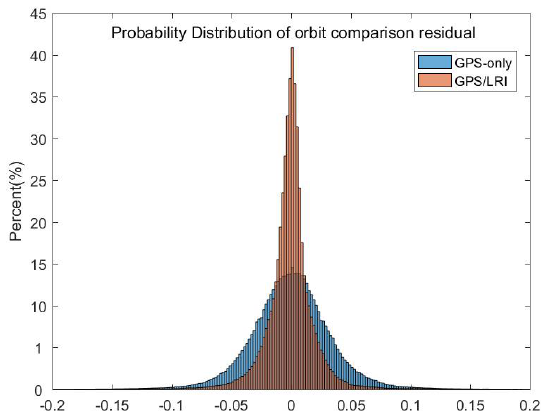
Figure 10. Reference orbit check for GRACE-FO-A in the R, S, W, 3D directions (days 212–242, ( a – d )).